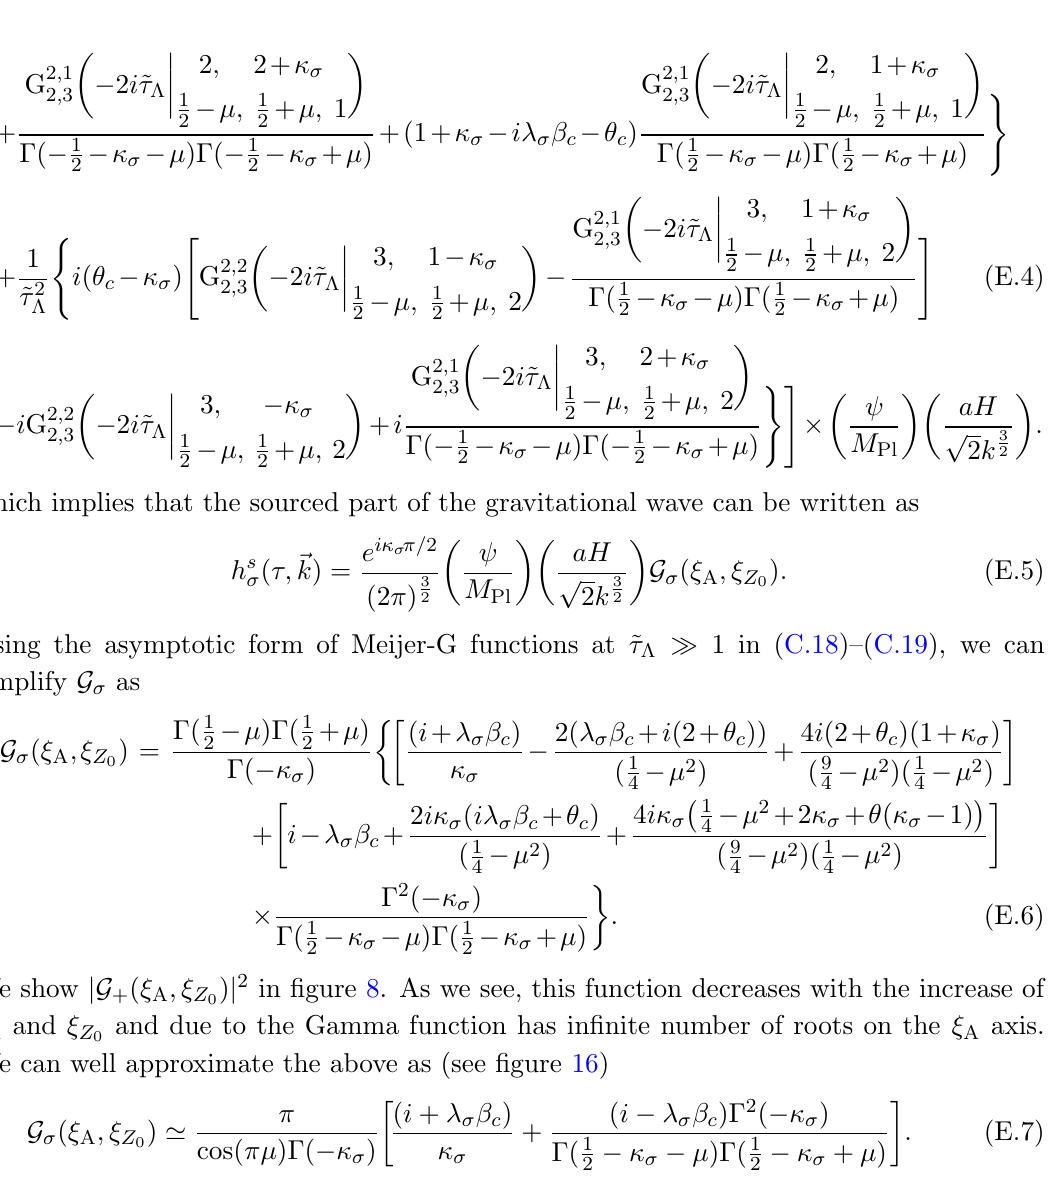
Figure 16 . The exact form of G (cid:27) ( (cid:24) A ; (cid:24) Z with respect to (cid:24) A for di(cid:11)erent values of (cid:24) Z dashed line on the top of each curve is its approximated